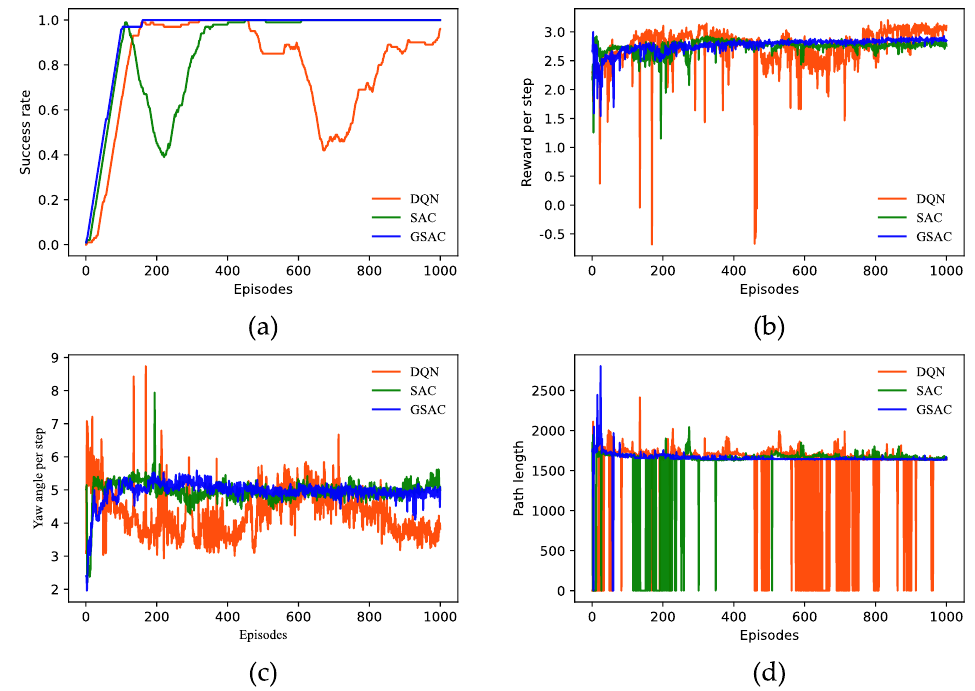
Figure 9. Static environment simulation curves. ( a ) Success rate (last 100 episodes).( b ) Reward per step. ( c ) Yaw angle. ( d ) Path length.